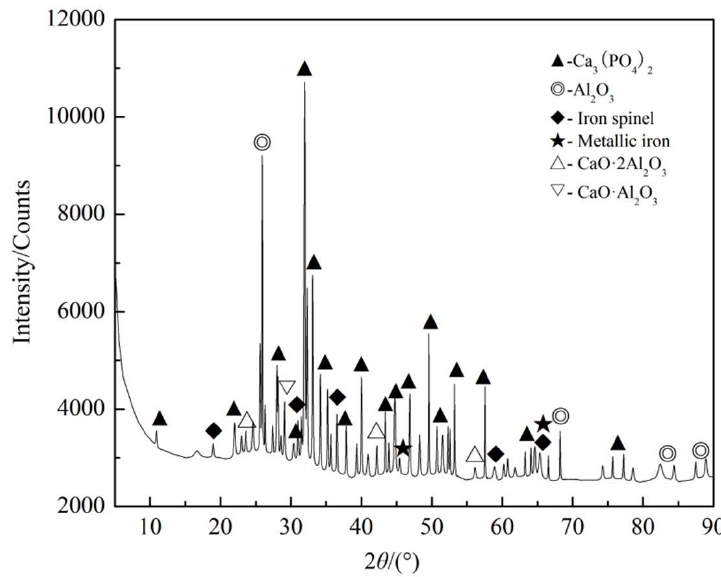
3 (PO 4 ) 2 –C–Fe 2 O 3 –Al 2 O 3 system.